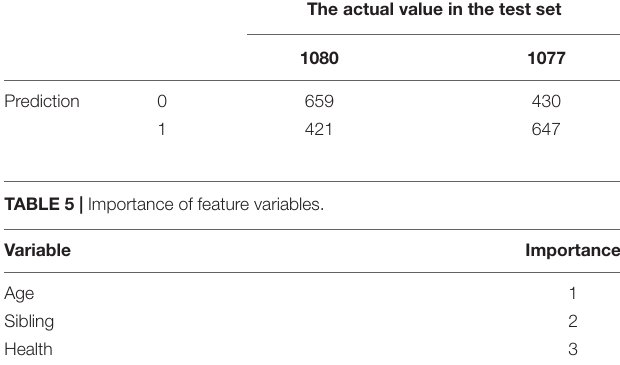
samples into two categories based on the values of the sample points, an optimal threshold is determined based on the ROC curve (subject operating characteristic curve), which is used as a threshold to segment the samples to achieve the highest accuracy of the classification results. The ROC curves in Figure 3 reflect the classification accuracy obtained with different values of the classification threshold. As demonstrated, the classification results are better when the threshold value is around 0.40. The best classification result is obtained when the threshold value is 0.40, and the AUC is the largest. The samples less than 0.40 are classified as “unwilling to have a second child,” and those greater than or equal to 0.40 are classified as “willing to have a second child.” The confusion matrix of classification results and